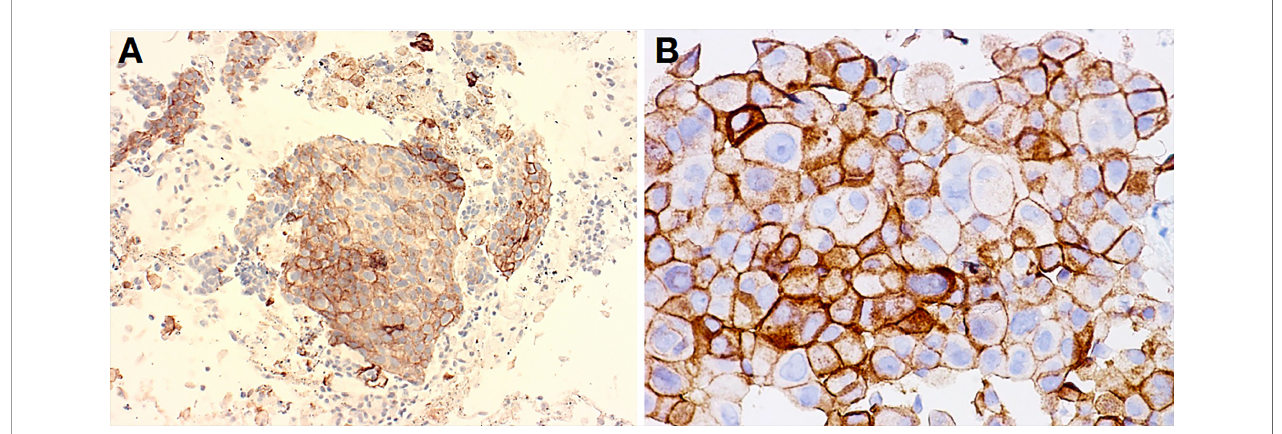
FIGURE 2 | Lung adenocarcinoma obtained with EBUS-TBNA procedure (A) and pleural effusion (cell block) (B) . These two cases of metastatic adenocarcinoma to a mediastinal lymph node (A) and pleura cavity (B) featured solid-clumped patterns of growth, which turned out positive for TTF1 and negative for p40, thus con fi rming the correct subtyping as required by the current WHO guidelines (not shown). When tumors were made to react with antibodies to PD-L1 within companion kits, clusters of tumor cells unequivocally revealed membrane decoration in more than 50% of them, thus suggesting amenability of immunotherapy. Clone Agilent-Dako 22C3 was developed in Autostainer Link 48, with original magni fi cation at ×400 (A) , while Ventana-Roche clone SP263 was developed in BenchMark Ultra IHC at ×200 (B)